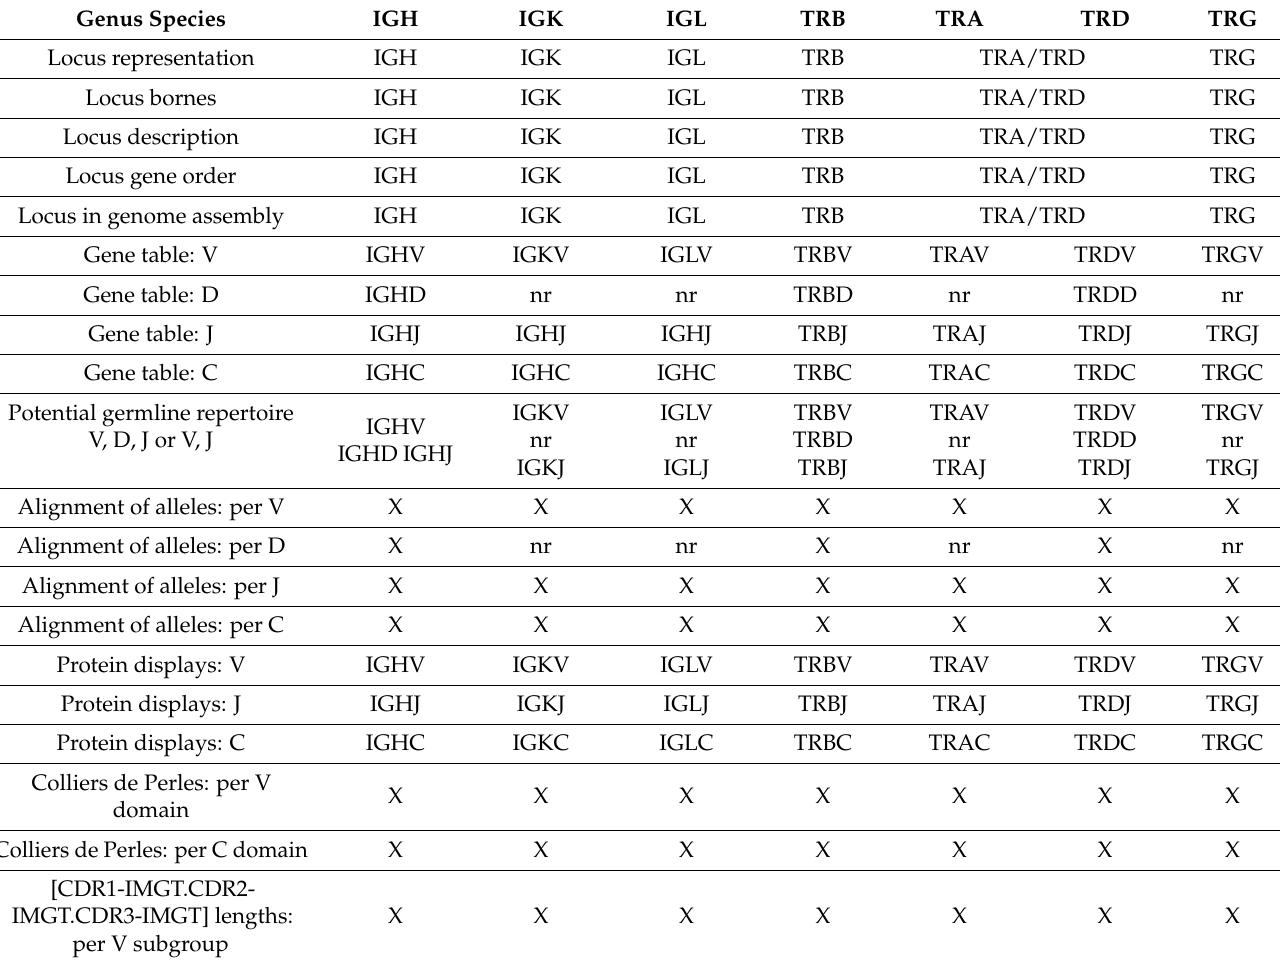
Table 10. IMGT ® Creations and updates: List of the web pages validated by IUIS NOM IMGT-NC. Genus